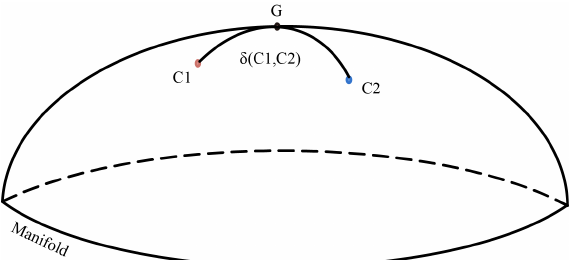
Figure 3. The distance between C1 and C2 is called Riemannian distance δ ( C 1 , C 2 ) , where G represents the Riemannian Geometry Mean of C1 and C2.